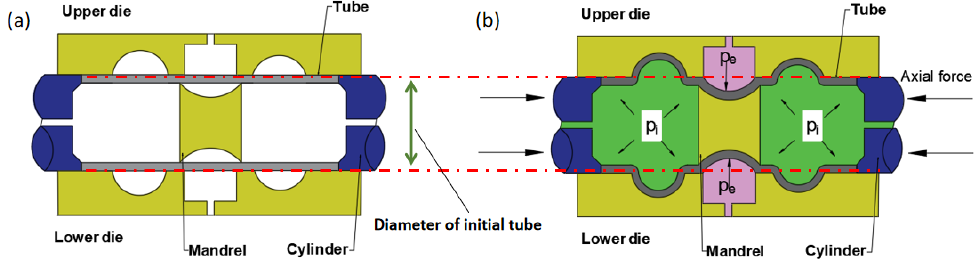
Figure 2. Principle of HIEP: ( a ) before HIEP and ( b ) after HIEP.